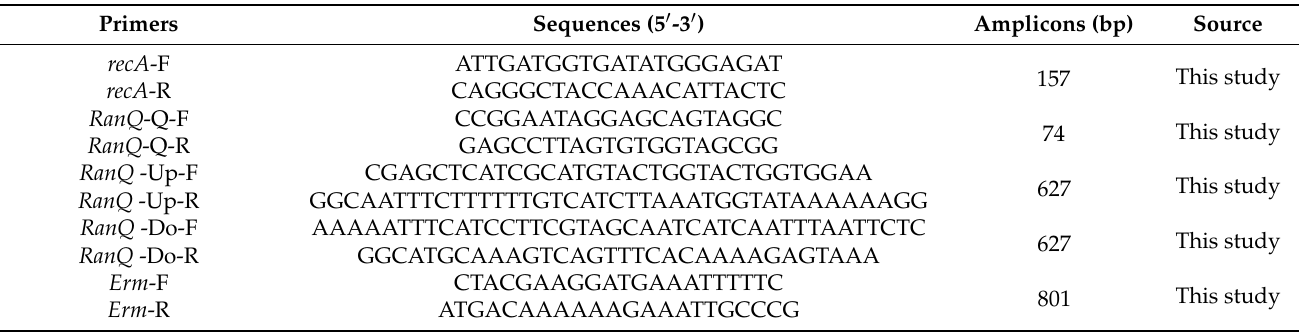
Table 2. This study used qRT-PCR and PCR